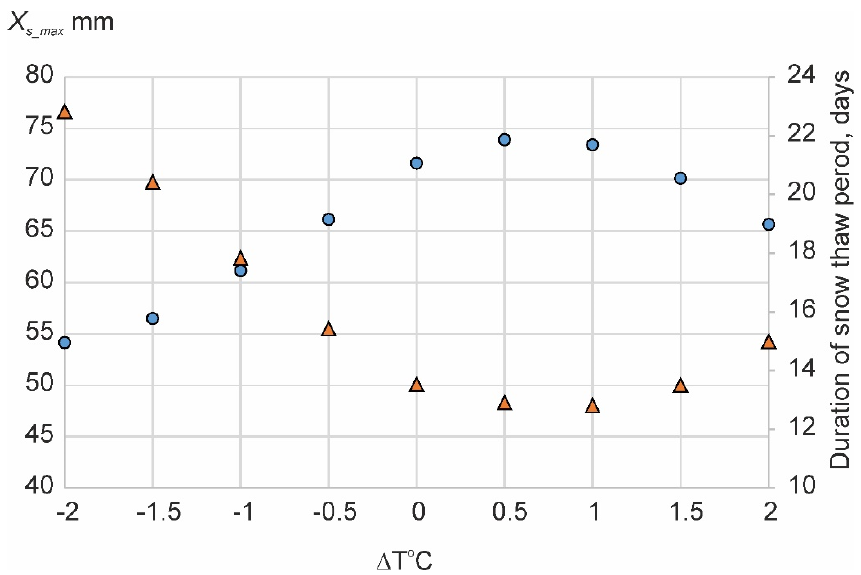
Figure 15. Changes in shape of hydrograph of daily runoff during the snow thaw period with variations of daily air temperatures, an example for 1992 year.